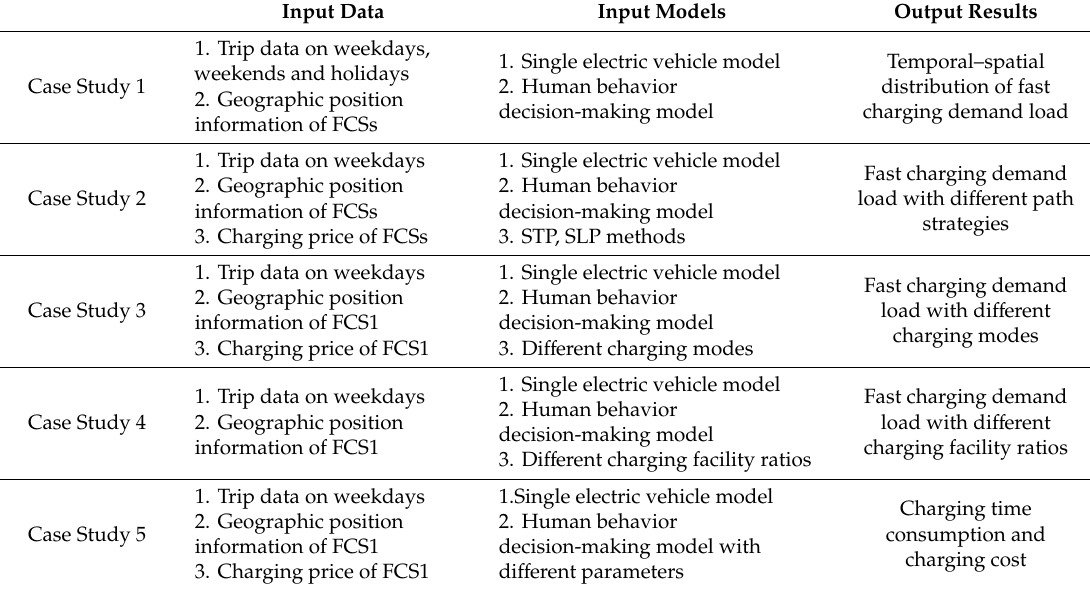
Table A5. Input–output data and used models in each case